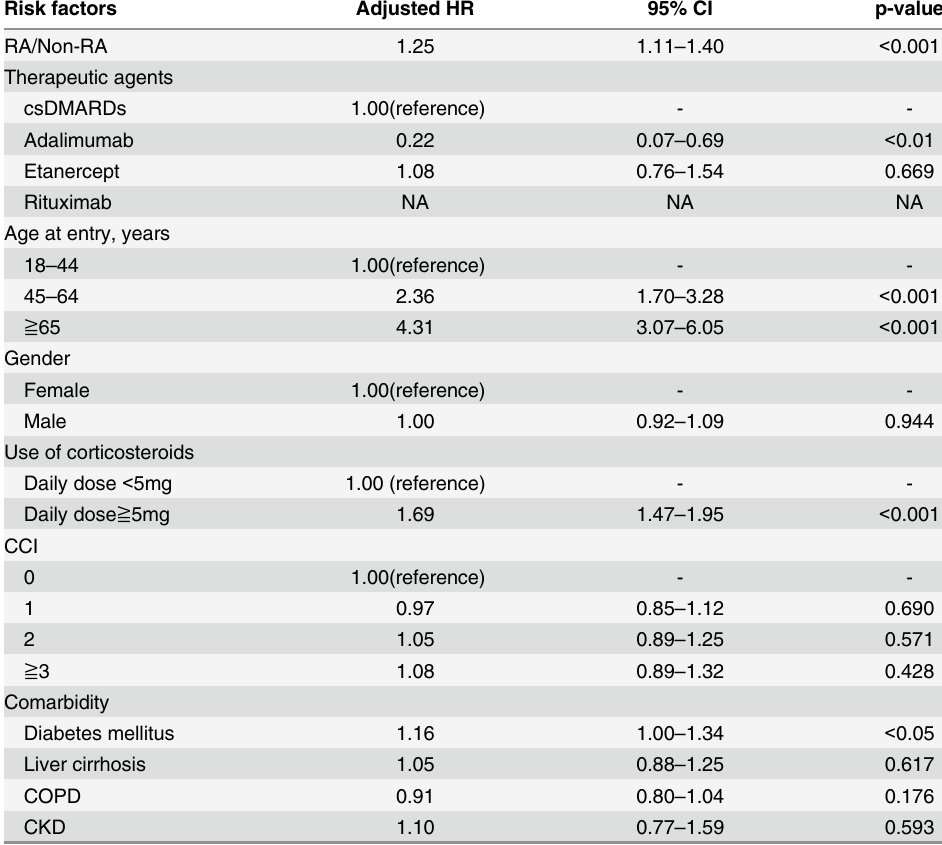
Table 4. Multivariable analysis for mortality after the diagnosis of tuberculosis (TB) in RA patients according to therapeutic agents and the risk factors of